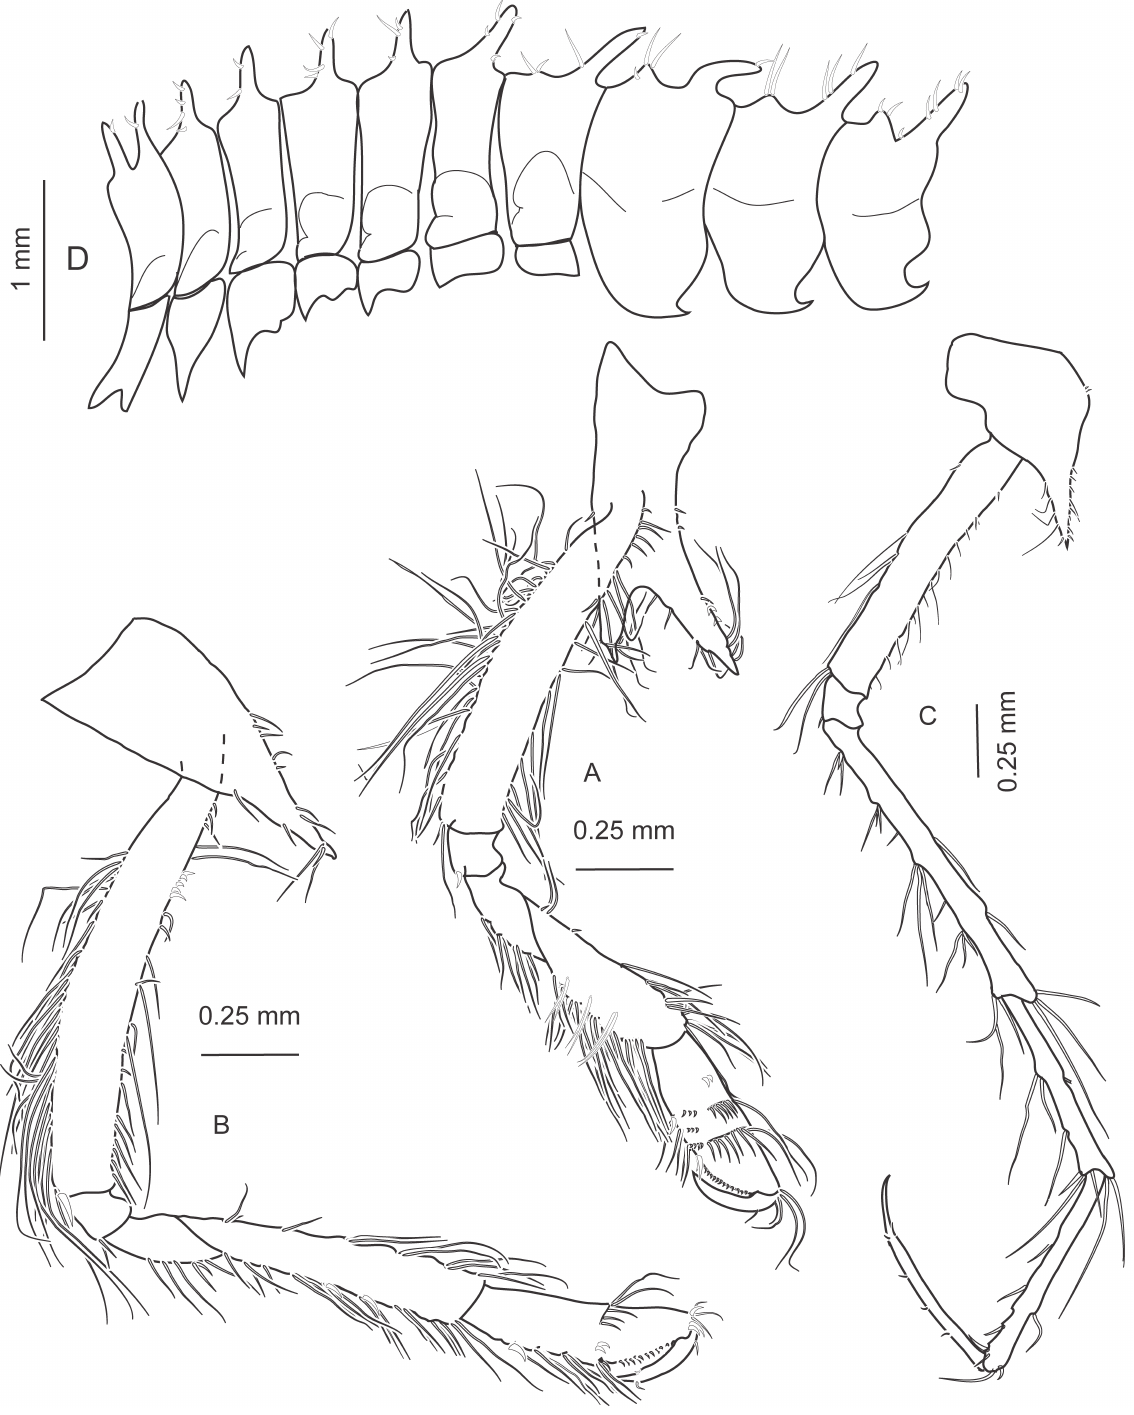
Fig. 3. Lepechinella arctica , holotype, ♀. A . Left Gn1. B . Right Gn2. C . Right P3. D . Peraeon and